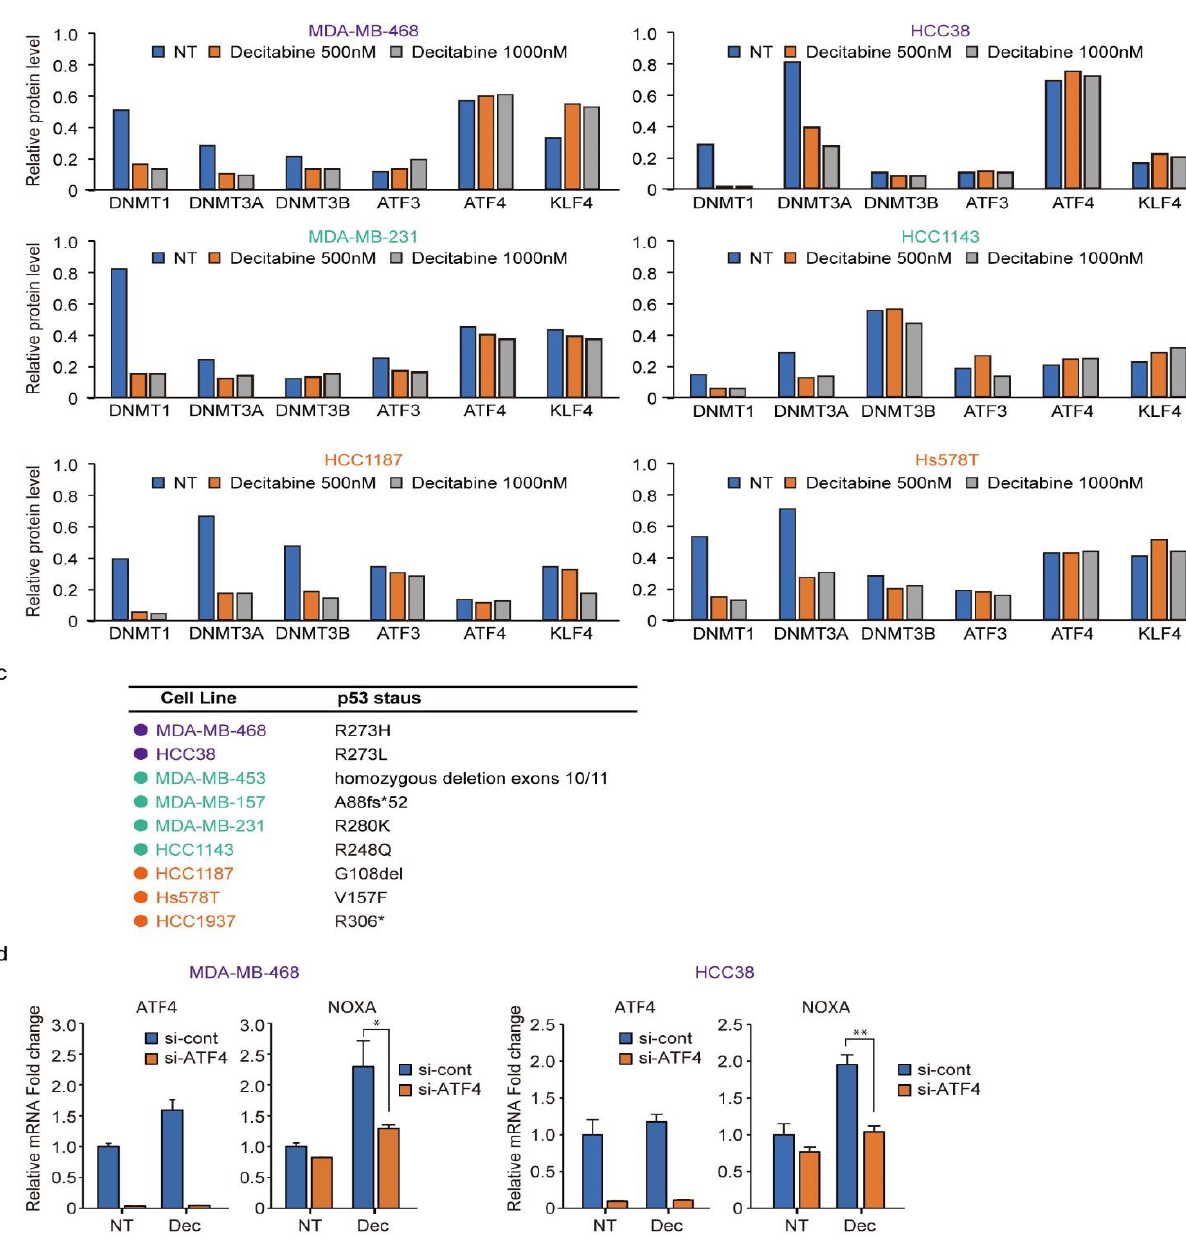
Figure 6. Levels of individual DNMT proteins do not correlate strongly with decitabine sensitivity. ( a ) Equal amounts of total cell lysate were subjected to immunoblot analysis with the indicated antibodies ( upper panel ). Protein expression levels were normalized to the loading control β -actin and fold change relative to the signal of loading control set to 1 ( lower panel ). ( b ) Each cell line was exposed to the indicated amounts of decitabine (500 or 1000 nM). After treatment for 72 h, equal amounts of total cell lysate were subjected to immunoblot analysis with the indicated antibodies. Numbers below blots represent the relative band intensity of each protein normalized to the signal intensity of β -actin ( upper panel ). Protein expression level were normalized to the loading control b-actin and fold change relative to the signal of loading control set to 1 ( lower panel ). The uncropped immunoblot images can be found in Figure S5. ( c ) Table showing the status of p53 in TNBC cell lines. ( d ) Cells were transfected with siRNAs (control-siRNA and siATF4). At 24 h after transfection, cells were exposed to 500 nM decitabine. After treatment for 72 h, mRNA levels in MBA-MB-468 ( left ) and Hcc38 ( right ) cells were measured by quantitative real-time PCR. Error bars indicate SD ( n = 3). Data are expressed as the mean ± SD of triplicate experiments. *, p < 0.05; **, p <